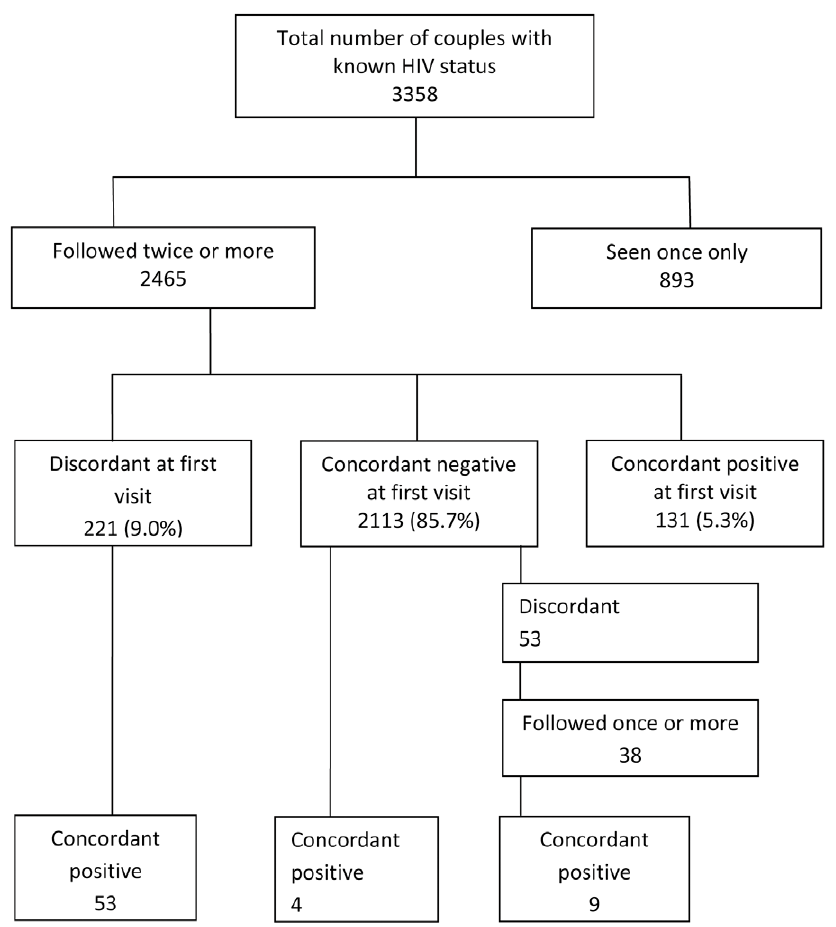
Figure 1. Identification of serodiscordant couples in the General Population Cohort.